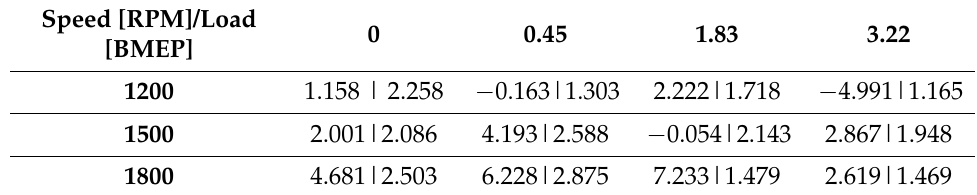
Table 5. Pmax error (%) | Ploc error (°) results for the studied engine states (speed and load are varied). The mean value of the pressure signals in the testing set is reported for each studied state.